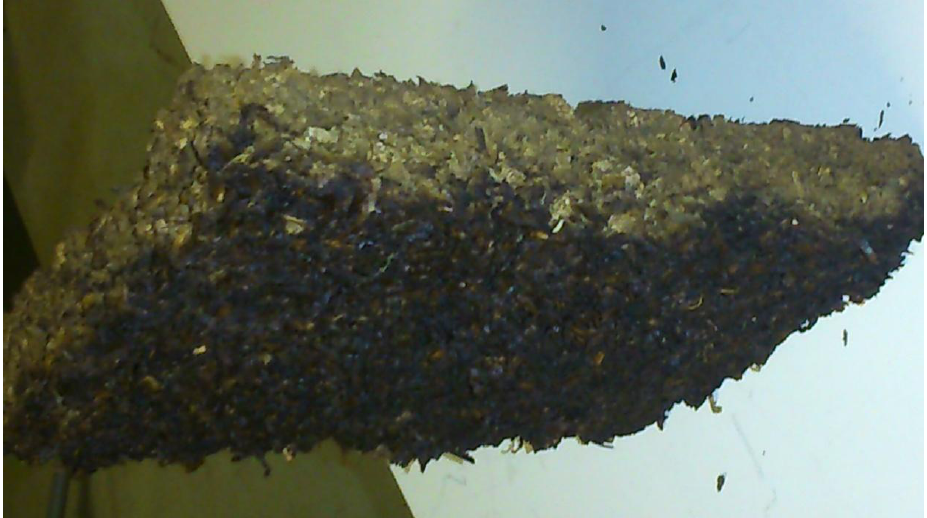
Figure 7. Impregnated sawdust at the end of the drying operation.